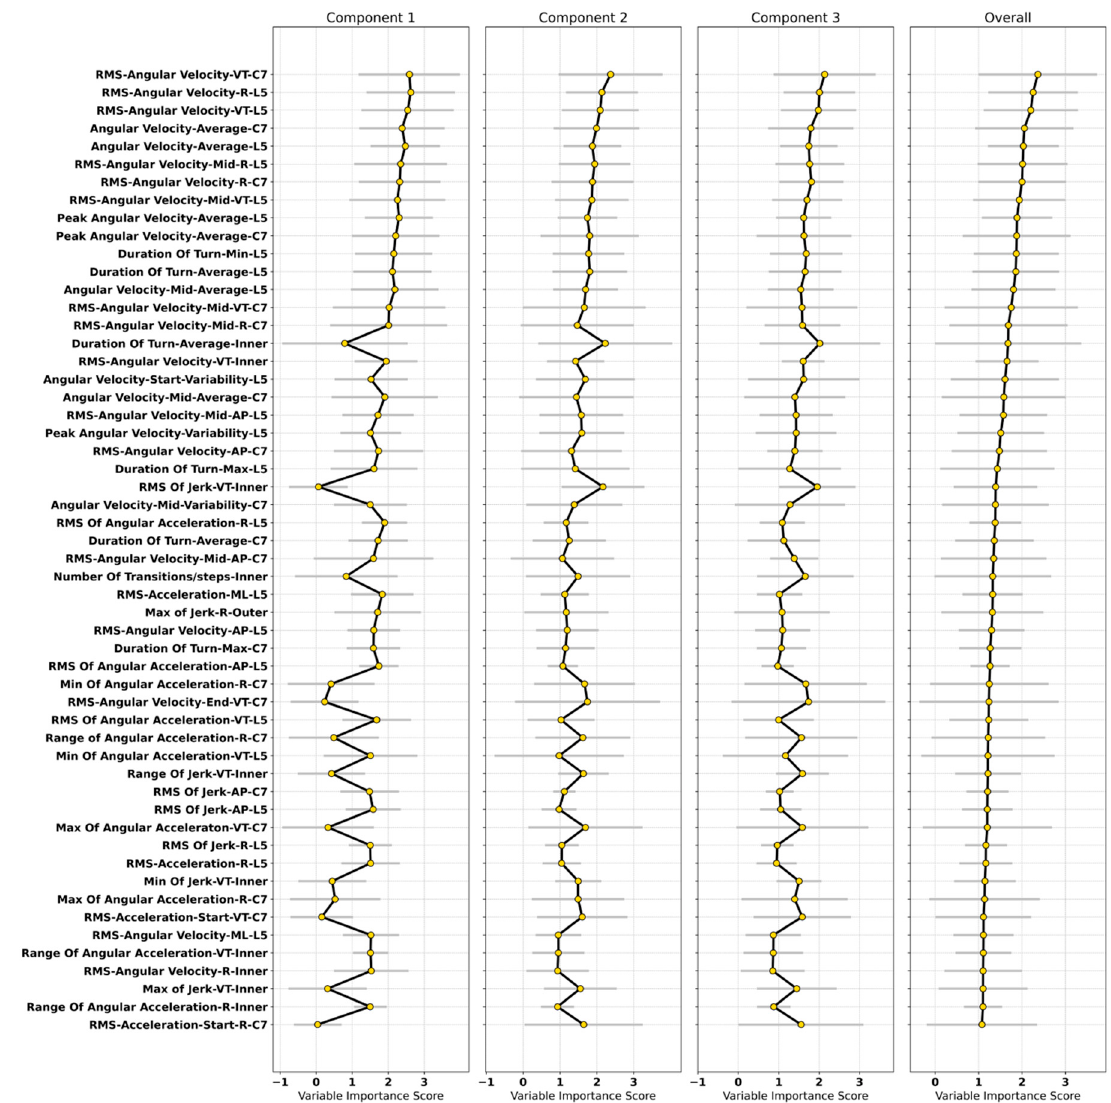
classification from a model (trained on the neck, lower back, inner and outer ankles) provided optimal balance in sensitivity and specificity.